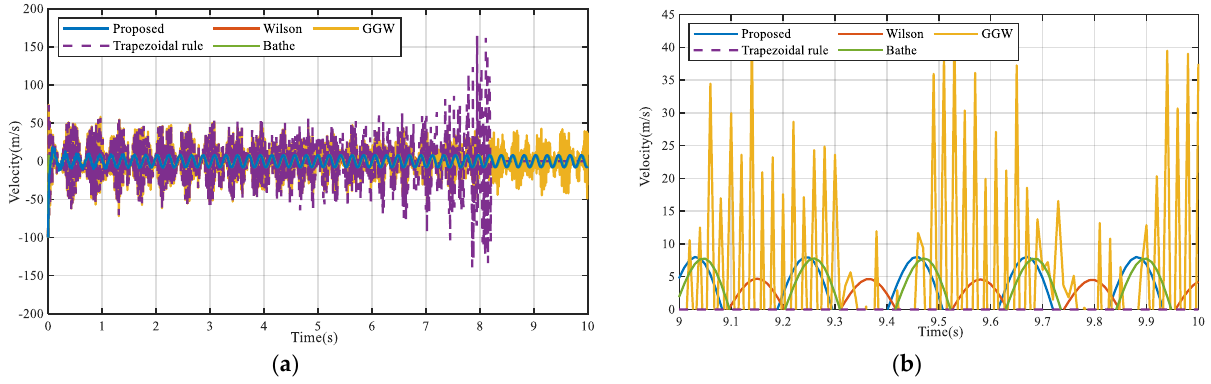
Figure 13. Displacement responses of Point A with the Wilson method, Bathe method, GGW method, trapezoidal rule, and the proposed method: ( a ) responses from 0 to 10 s; ( b ) partial enlarged drawing of responses from 9 to 10 s.